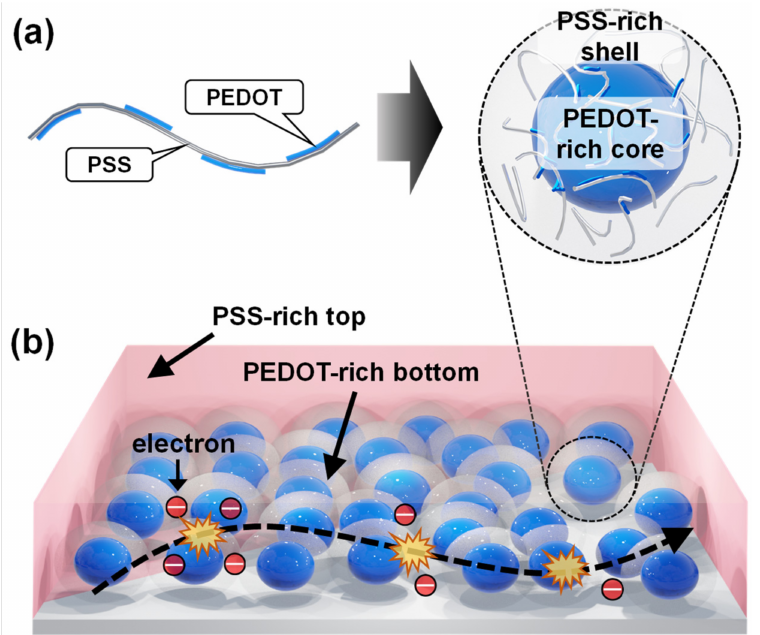
Figure 1. Schematic illustration of the ( a ) core-shell structure of PEDOT:PSS and ( b ) discontinuous distribution of conductive PEDOT in a coated pristine PEDOT:PSS